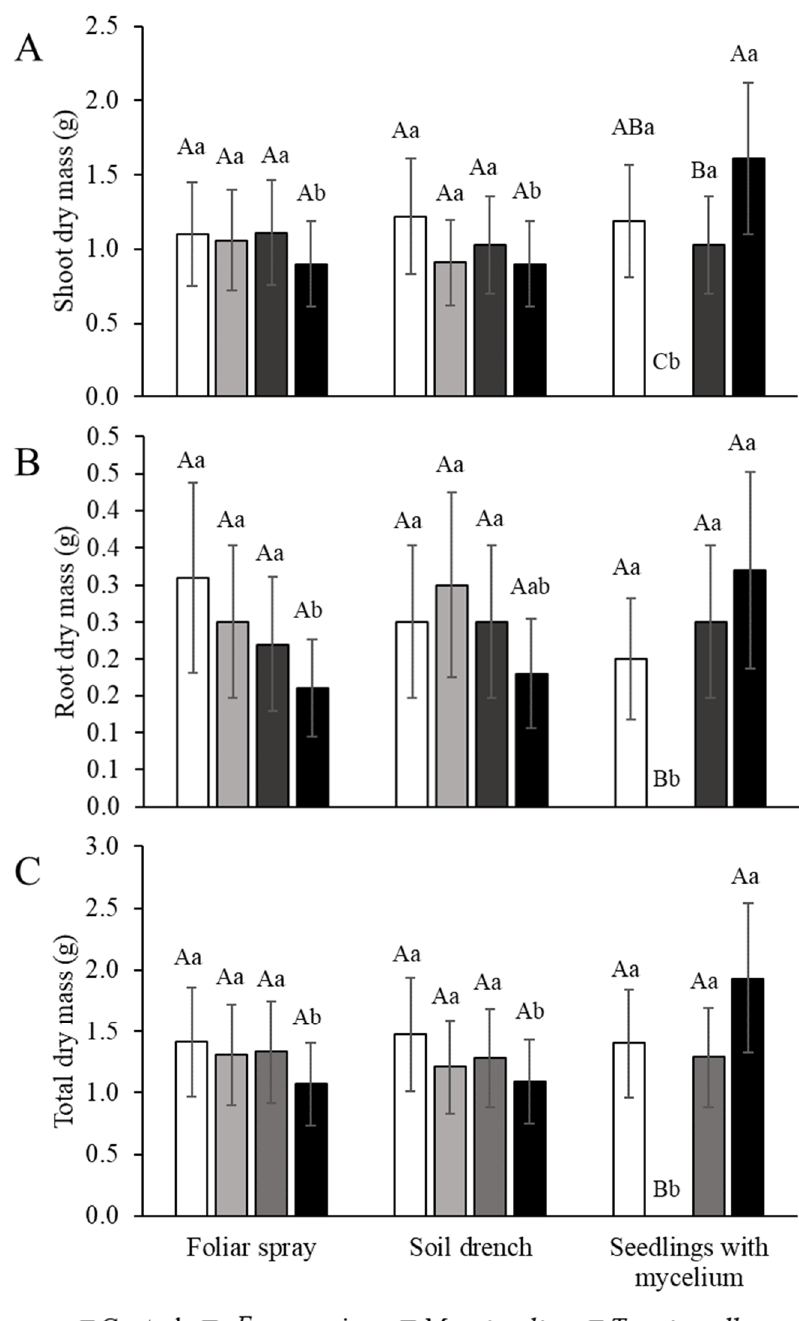
Figure 4. Biometric characteristics of Eucalyptus urophylla in response to inoculation methods (Foliar spray, soil drench, and seedlings with mycelium) and inoculated fungal species ( Escovopsis sp., Metarhizium anisopliae , and Trichoderma strigosellum ). ( A ) Shoot dry mass (g), ( B ) Root dry mass (g), and ( C ) Total dry mass (g). Mean values with the same uppercase letter indicating the effects of the fungi or lowercase letter indicating the effects of the methods did not differ, as per Tukey test ( p < 0.05). Each column corresponds to the mean of five plants ± standard errors